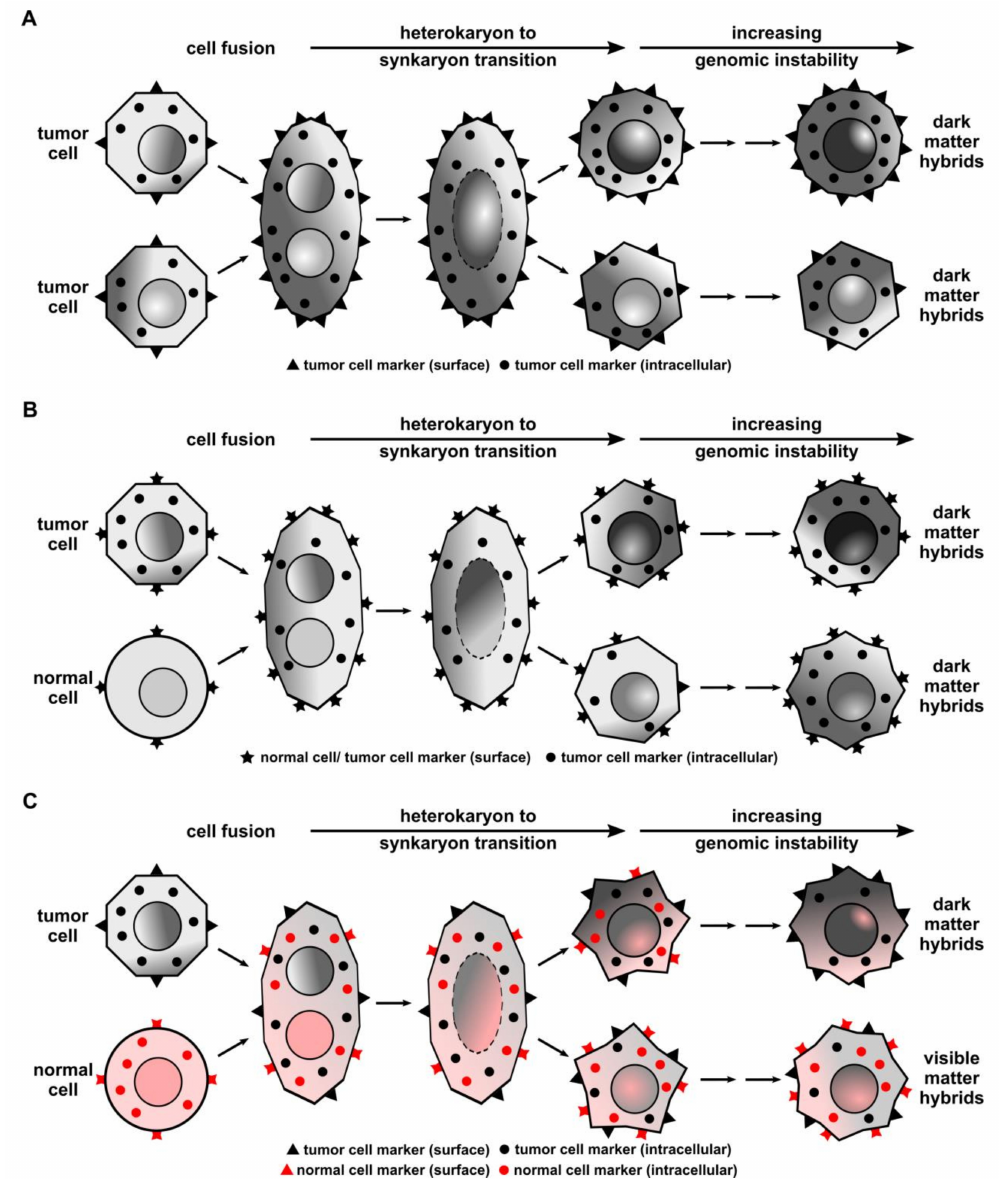
Figure 1. Model of how dark matter hybrids may originate. Tumor cells can either fuse with other tumor cells (homotypic fusion) or normal cells (heterotypic fusion), resulting in a heterokaryon (a hybrid cell with at least two nuclei). Hybrid cells can undergo a process known as the heterokaryon-to-synkaryon transition (HST), which is the merging of the parental chromosomes and random distribution to (at least) two daughter cells with one nucleus (synkaryon). A solid-colored nucleus represents the unchanged karyotype of a normal cell, whereas the altered karyotype of a tumor cell is presented as a gradient colored nucleus. HST is a potent inducer of genomic instability and most hybrid cells will die or will be less capable of proliferation (not shown here). ( A ) Homotypic tumor cell fusion results in dark matter hybrids that are indistinguishable from parental cells. ( B ) Heterotypic fusion of a tumor cell and a normal cell both exhibiting a similar specific marker pattern also results in dark matter hybrids that are indistinguishable from parental cells. ( C ) Heterotypic fusion of a tumor cell and a normal cell exhibiting a specific discrimination marker pattern. Due to genomic instability one TN-hybrid cell loses discrimination markers over time and becomes a dark matter hybrid. In contrast, the other TN-hybrid cell retains discrimination markers and becomes part of the visible matter